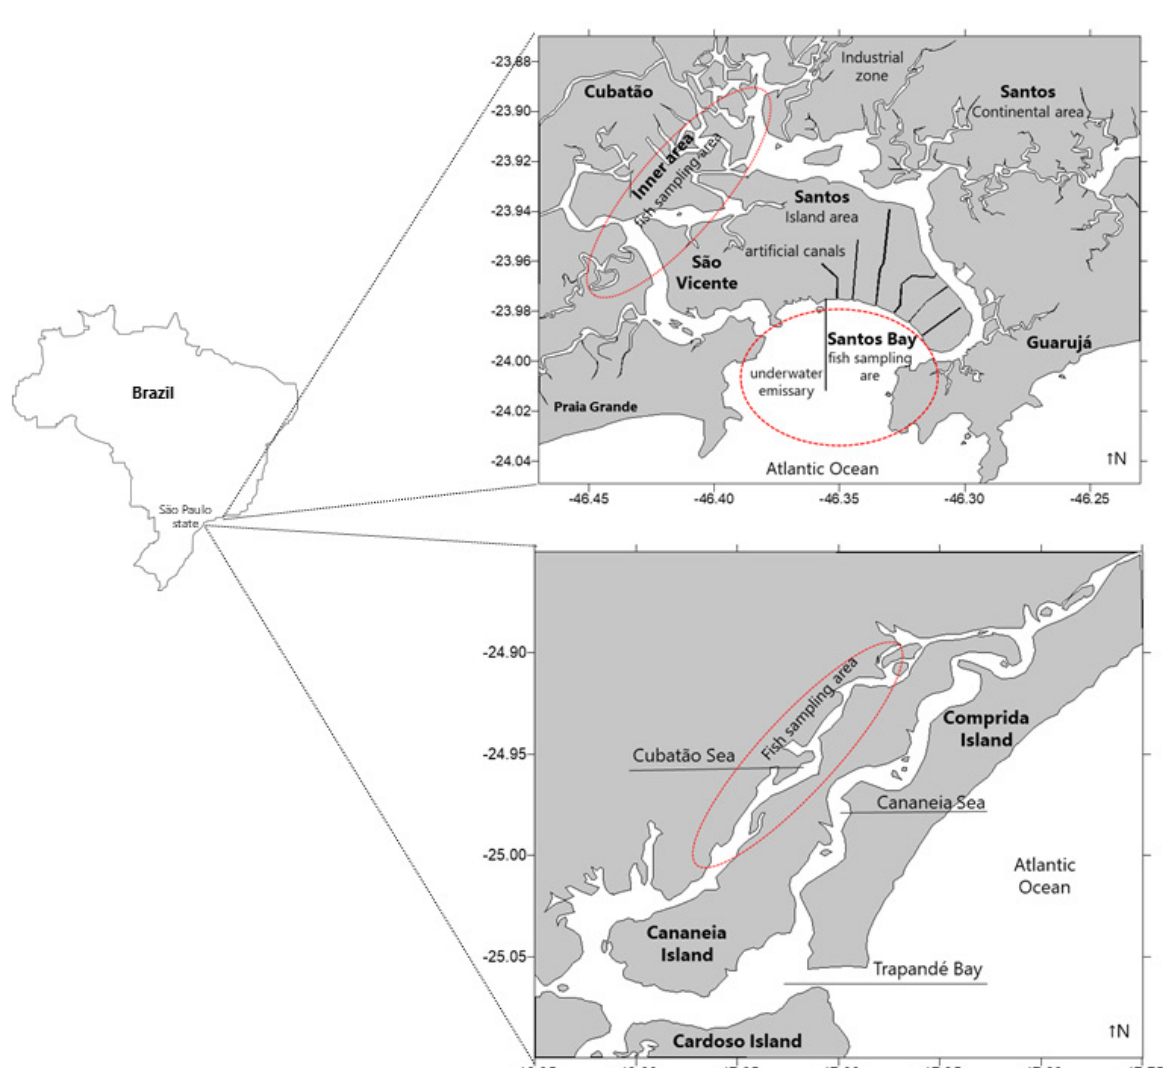
Figure 1 - Sampling sites showing the areas of fish collection in Santos/São Vicente (SSV) and Cananeia estuary, São Paulo,